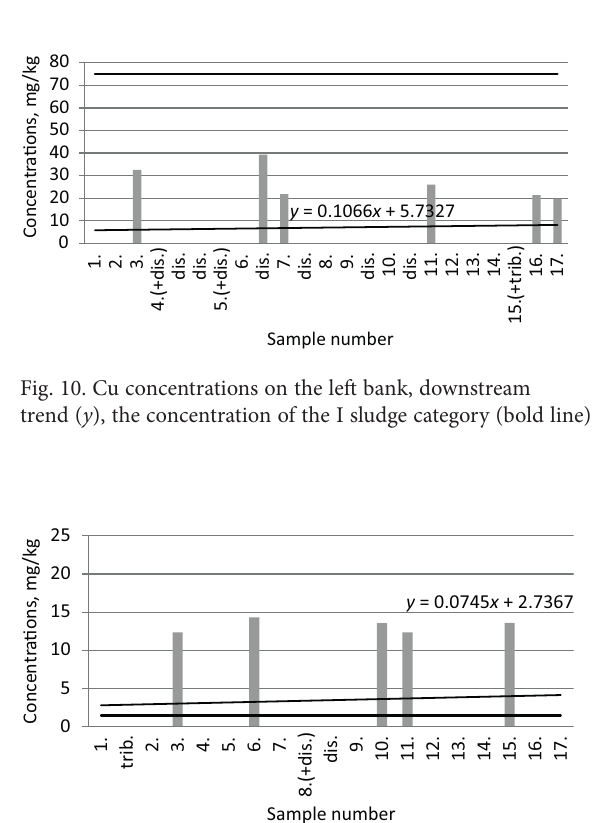
Fig. 9. Cu concentrations on the right bank, downstream trend ( y ), the concentration of the I sludge category (bold line)